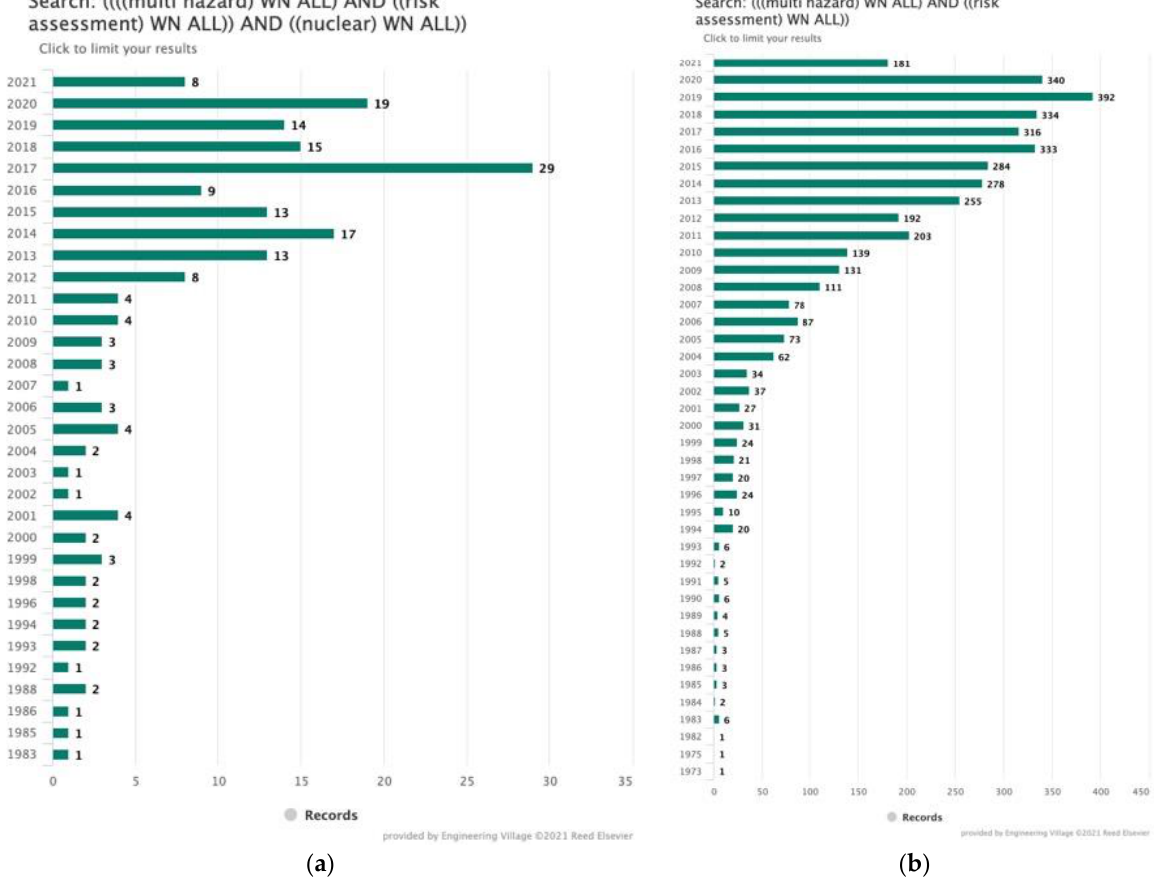
Figure 1. Literature search based on multi-hazard risk assessment on nuclear ( a ) and non-nuclear research ( b ) . Multi-hazard PRA became a topic after the Fukushima NPP accident in March 2011. Table 1. Multi-hazard categorization